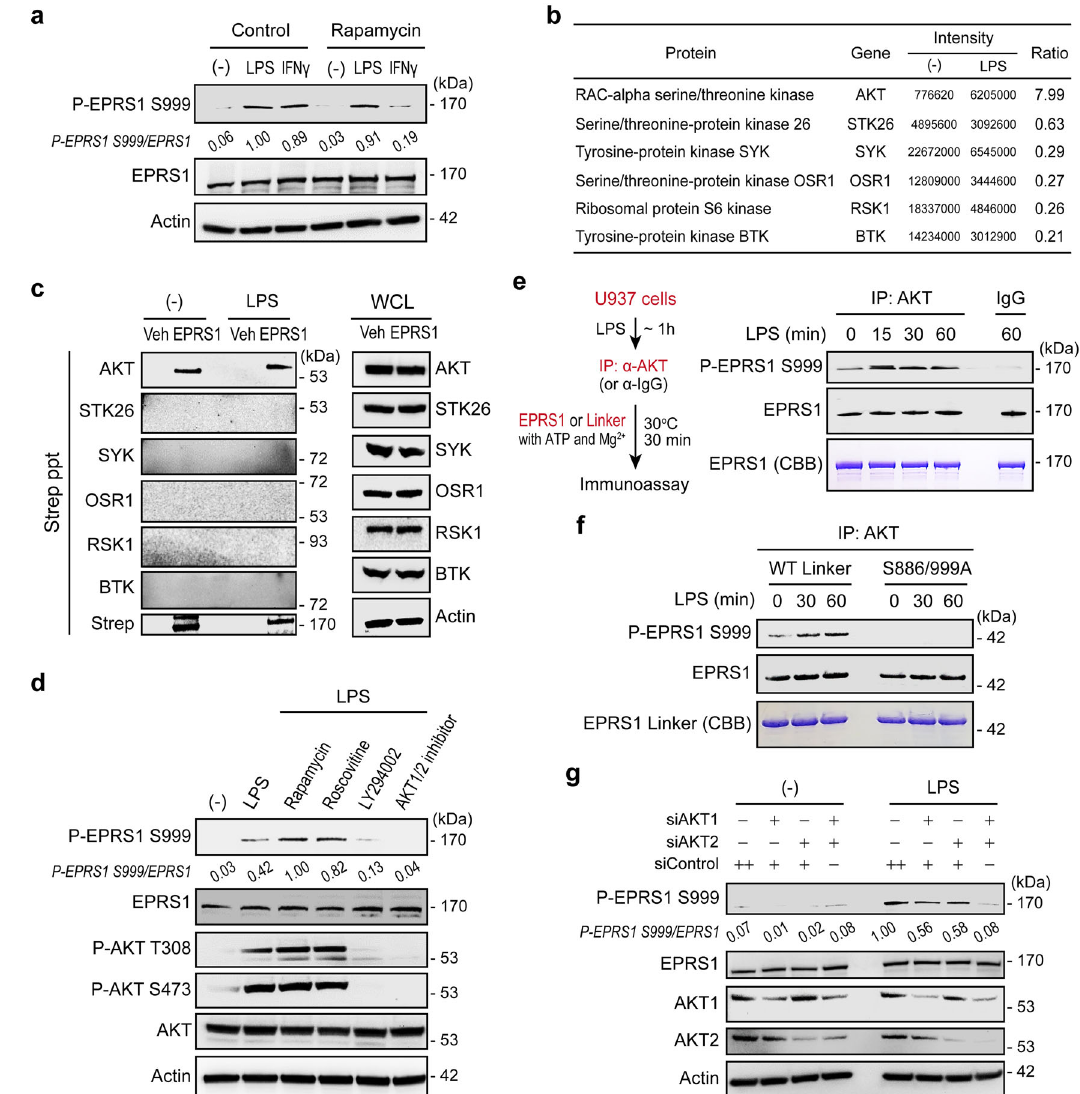
Fig. 2 | In fl ammatory-activated AKT phosphorylates EPRS1 at Ser999. a Immunoblot analysis of EPRS1 Ser999 phosphorylation in U937 cells treated for 4h with LPS (100ng/ml) or IFN γ (100ng/ml). For pharmacological inhibition, cells were either untreated (control) or pretreated with rapamycin (10nM) 30min before stimulation with LPS or IFN γ . The ratio of phosphorylated/total EPRS1 is shown as p-EPRS1/EPRS1. b Proteomic analysis identi fi ed candidate kinases that bind preferentially to EPRS1. Protein intensity ratios under unstimulated ( − )/sti- mulated (LPS) conditions are shown. c U937 cells, unstimulated ( − ) or stimulated withLPS(100ng/ml)for1h,werelysedandincubatedwithvehicle(Veh)orpuri fi ed Strep-EPRS1. The incubated cellswere pulled downwith Strep-Tactinbeads for 1h, andprecipitatesofendogenouskinaseswereanalyzedbyimmunoblottingwiththe indicated antibodies. d U937 cells were pretreated with rapamycin (10nM), ros- covitine(10 μ M),LY294002(5 μ M),oranAKT1/2inhibitor(5 μ M)for30minbefore LPS (100ng/ml) stimulation. After 1h, cells were harvested and the lysates were analyzed by immunoblotting with the indicated antibodies. The calculated ratio